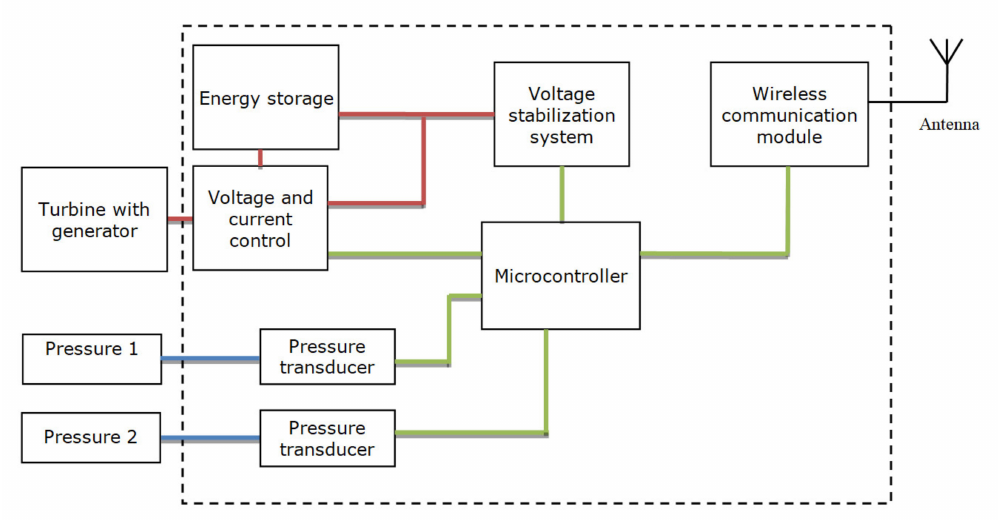
Figure 5. Block diagram of the measuring